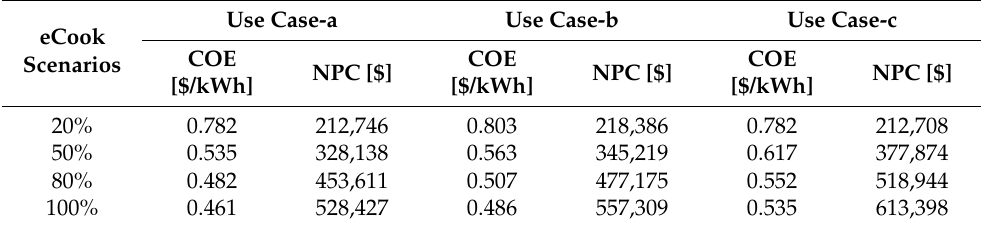
Table 9. Comparison of the economics of the different cases. eCook